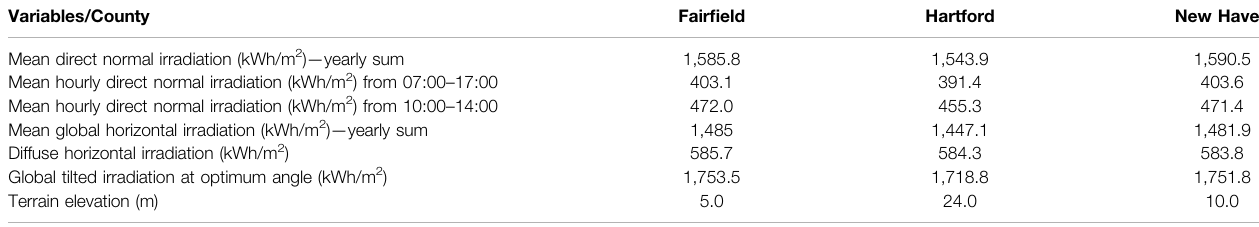
TABLE 4 | Summary of the averages of the direct normal irradiation, global horizontal irradiation, diffuse horizontal irradiation, and other parameters. Variables/County